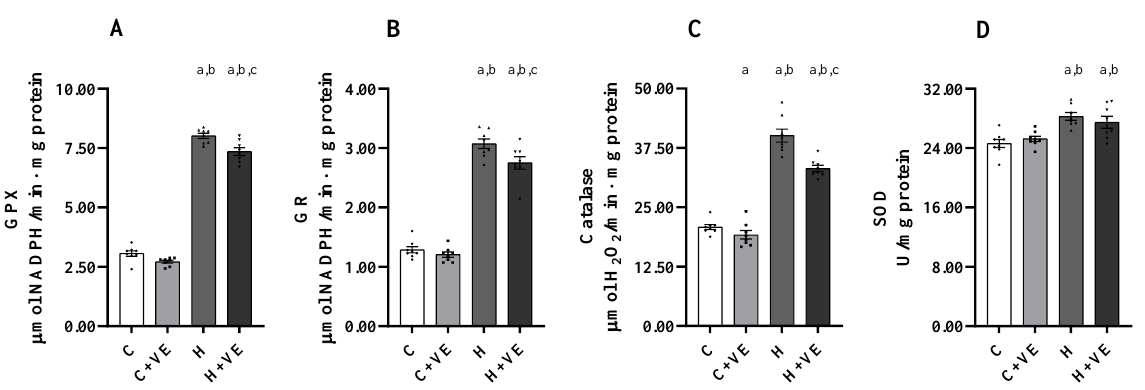
Figure 4. Antioxidant enzyme activities. GPX (panel ( A )), GR (panel ( B )) catalase (panel ( C )), and SOD (panel ( D )). C control rats; C + VE, vitamin-E-fed rats; H hyperthyroid rats; H + VE hyperthyroid and vitamin-E-fed rats. Values are the means ± SEM of eight different rats. p < 0.05 was chosen as the significance level. Meaning of the letters: a, p < 0.05 vs. C; b, p < 0.05 vs. C + VE; c, p < 0.05 vs. H (one-way ANOVA followed by Tukey